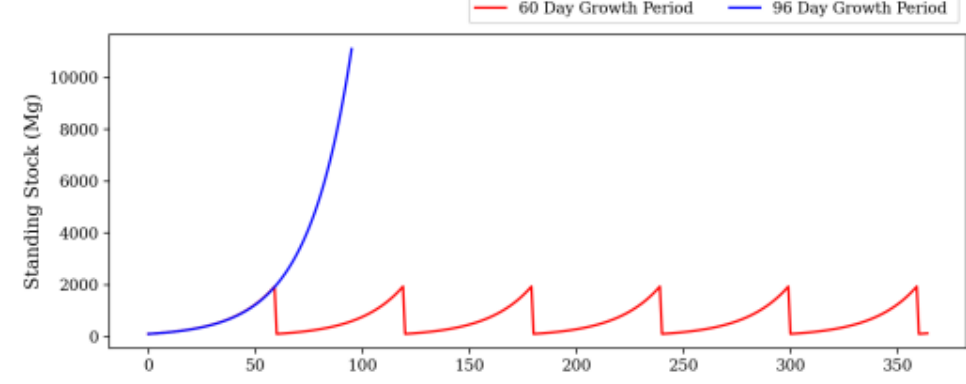
Figure 11. Growth Period Trade-off.